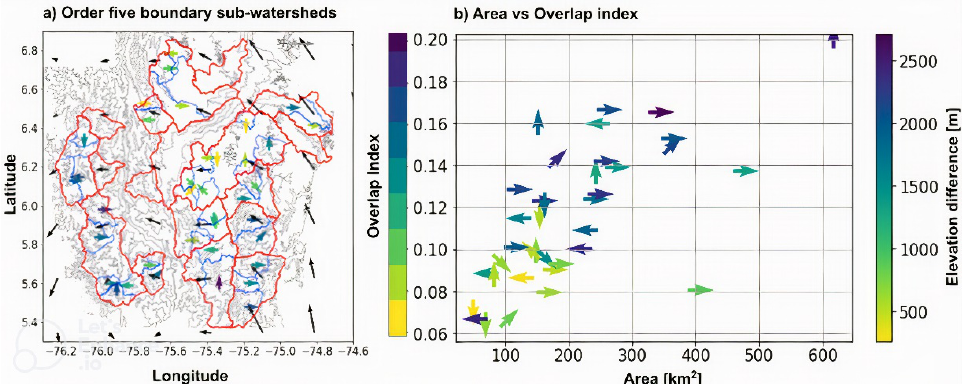
Figure 12. Spatial distribution of the overlap index for the boundary sub-watersheds or orders 5. In panel ( a ), the blue lines represent the sub-watersheds, the colored arrows the aspect (direction) and the overlap index (color), and the black arrows represent the ERA-5 wind at 750 hPa. In panel ( b ), the arrows represent the aspect, and their color is the elevation difference.